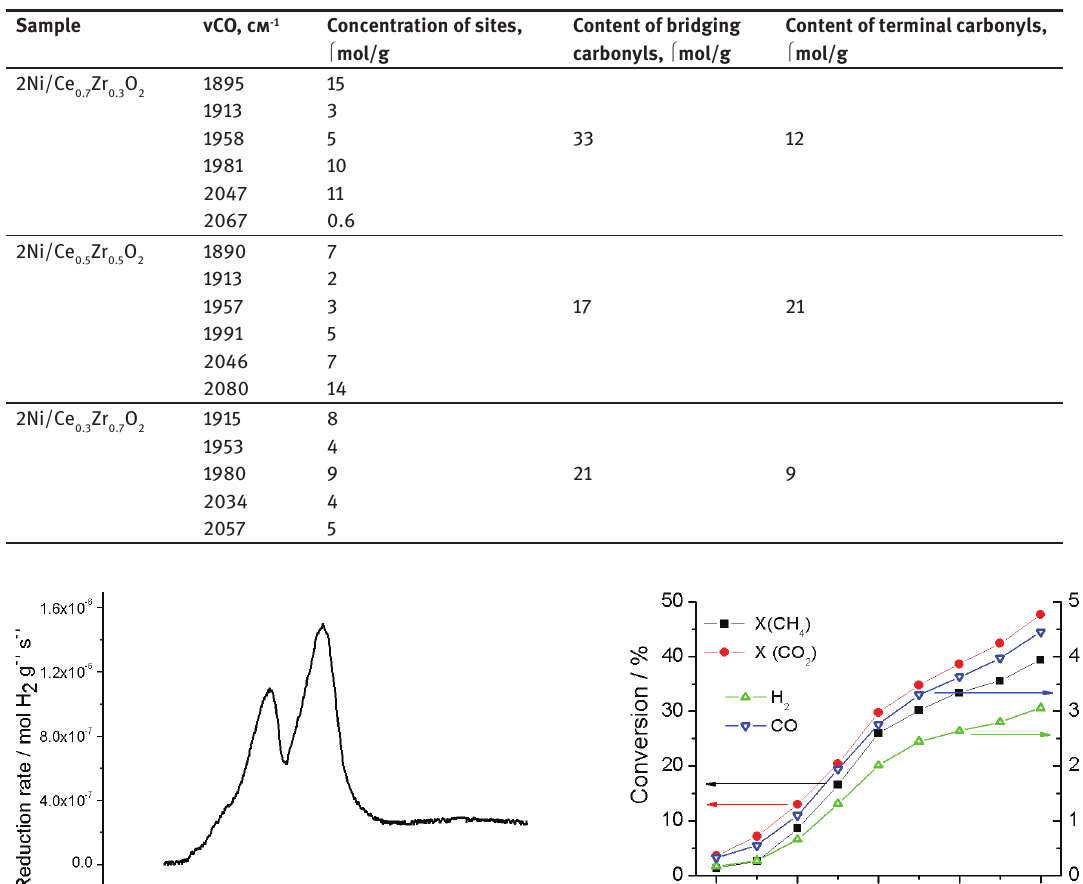
Table 4: Concentration of different types of Ni 0 centers by FTIRS of adsorbed CO data. Sample νCO, см -1 Concentration of sites,  mol/g